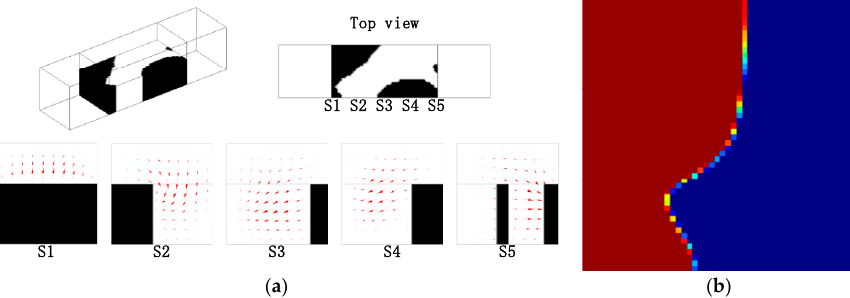
Figure 5. ( a ) Layout of the micromixer for the design domain as shown in Figure 4, where n = 2, Re = 2.5, and projected velocity vector distribution in the cross sections (S1, S2, S3, S4, S5); the mixing measurement